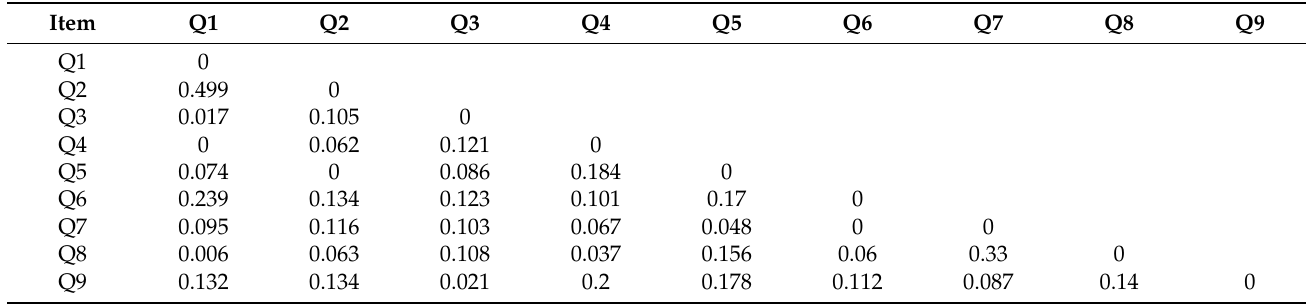
Table A1. Weights matrix in